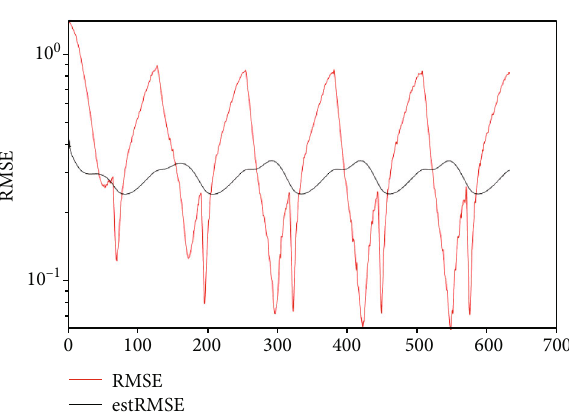
Figure 2: Results of error comparison analysis based on